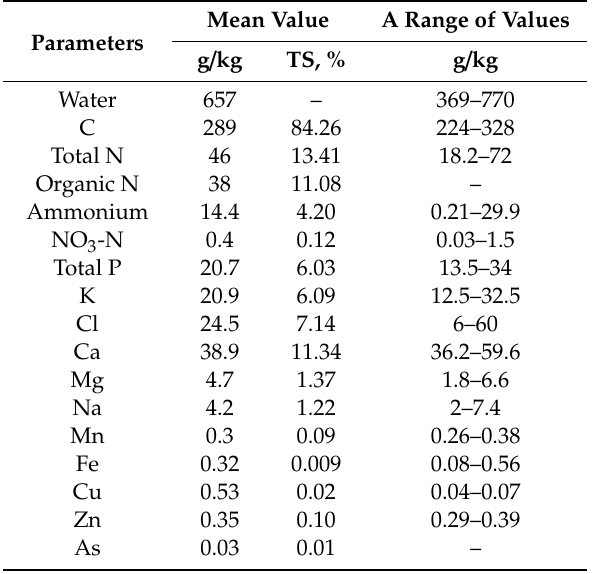
Table 1. Comparison of dry anaerobic digestion (AD) technologies